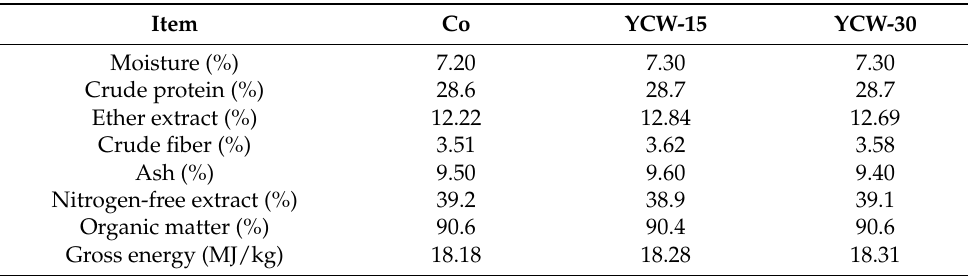
Table 1. Chemical composition of experimental